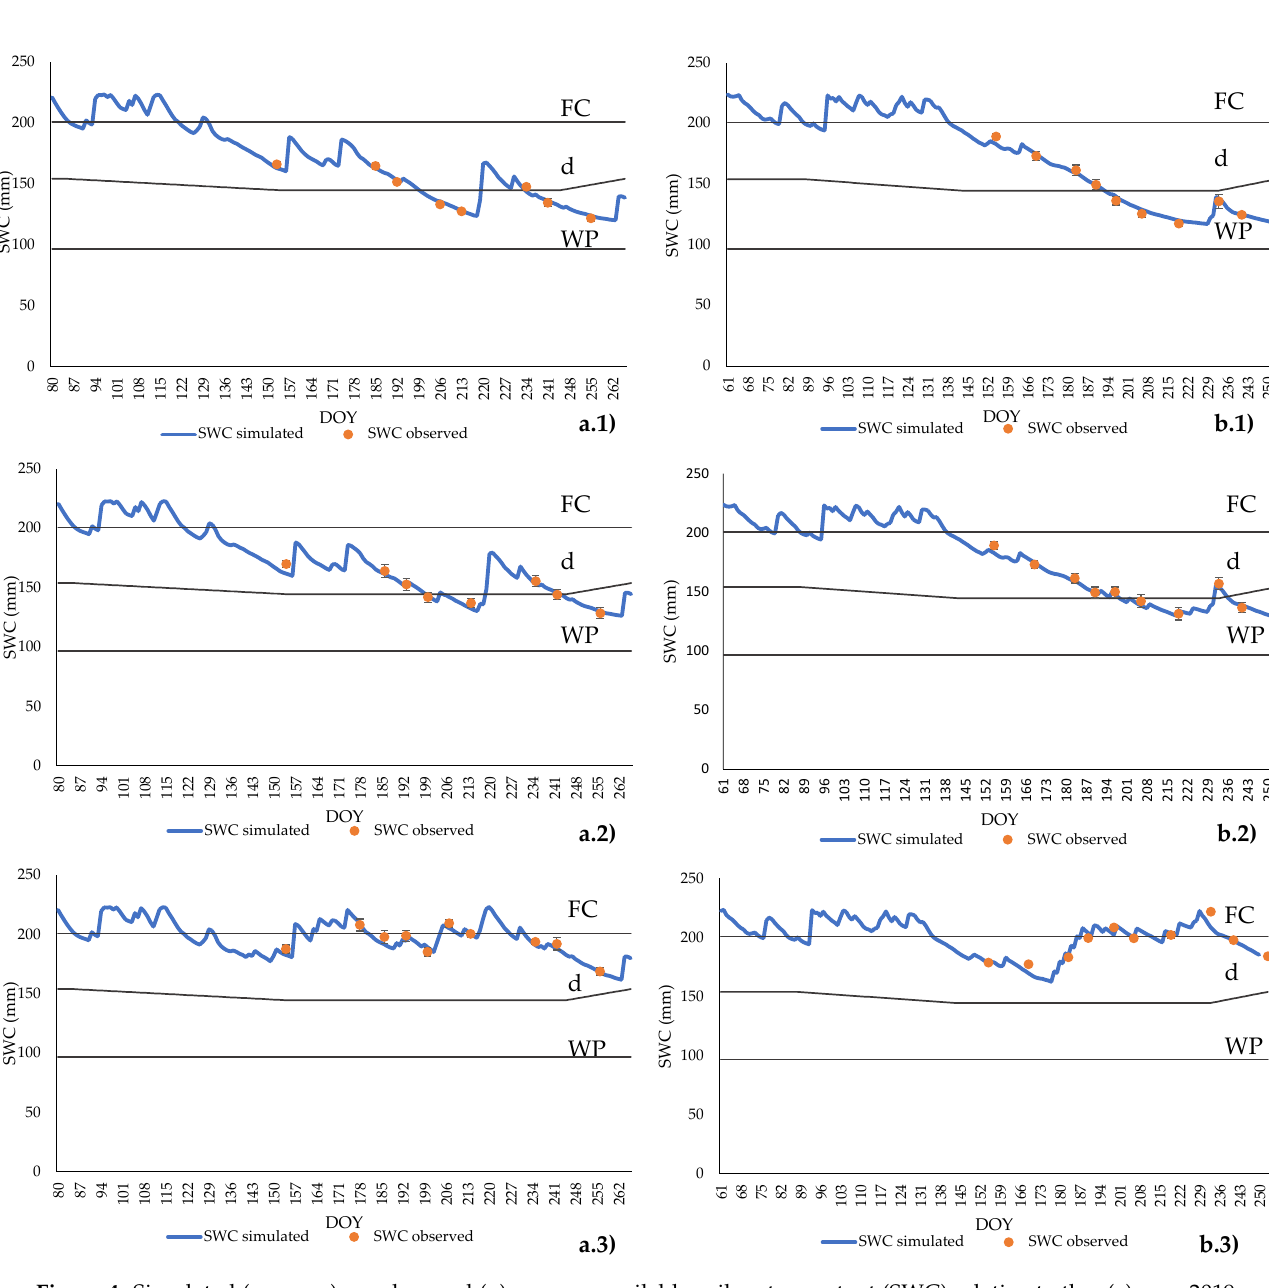
Figure 4. Simulated ( ) vs. observed ( ) average available soil water content (SWC) relative to the: ( a ) year 2019, ( b ) year 2020; (1) rainfed (R), (2) deficit irrigation (DI), (3) full irrigation (FI). DOY represents the day of the year. Error bars represent the standard deviation of the mean observed values. Curves FC, WP, and d represent the soil water content at field capacity, wilting point, and d the soil water content when depletion equals the p fraction, respectively.